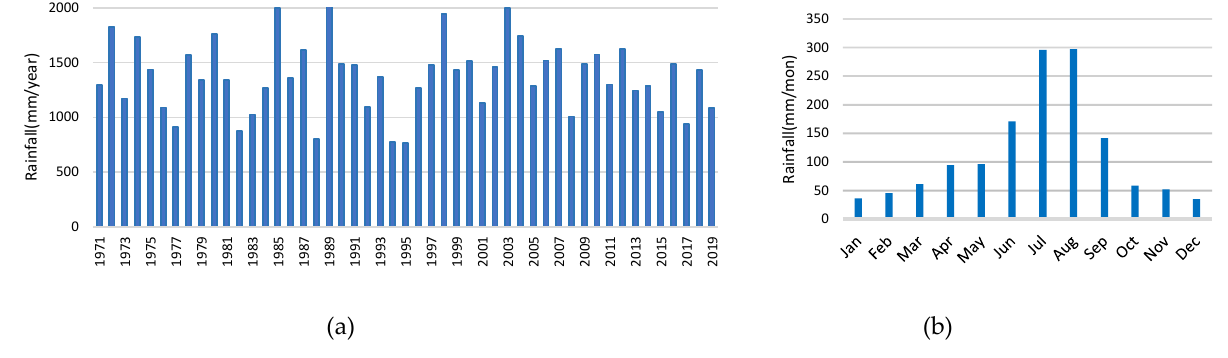
Figure 2. ( a ) Annual average precipitation. ( b ) Monthly average precipitation.